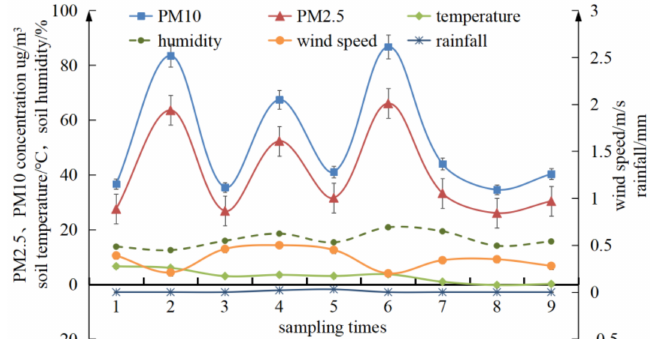
Figure 17. Huairou stubble+straw mulching.